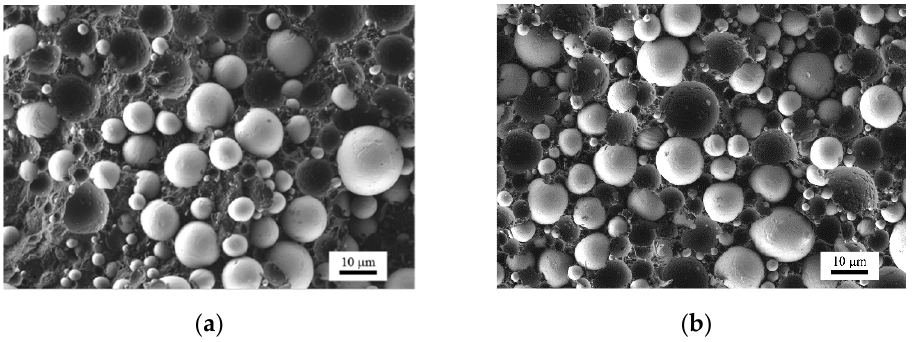
Figure 6. Scanning electron micrographs of compression-molded samples of ( a ) the Ti feedstock with 50 vol.% metal loading and ( b ) the Ti feedstock with 60 vol.% metal loading.